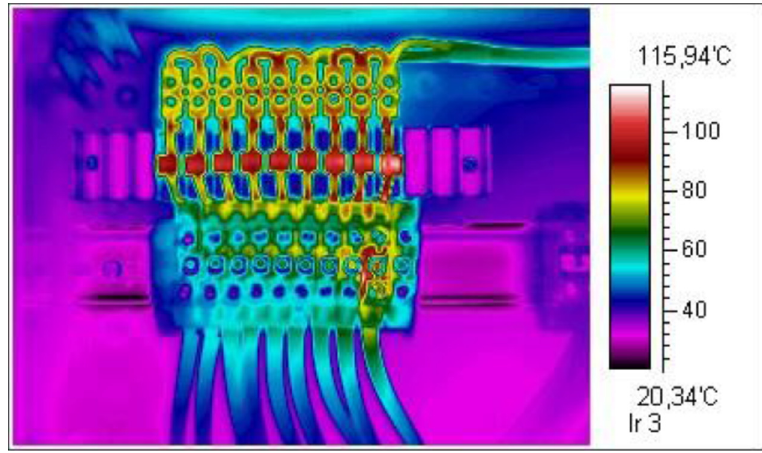
Figure 17. Overheated wires in DC string box [28].